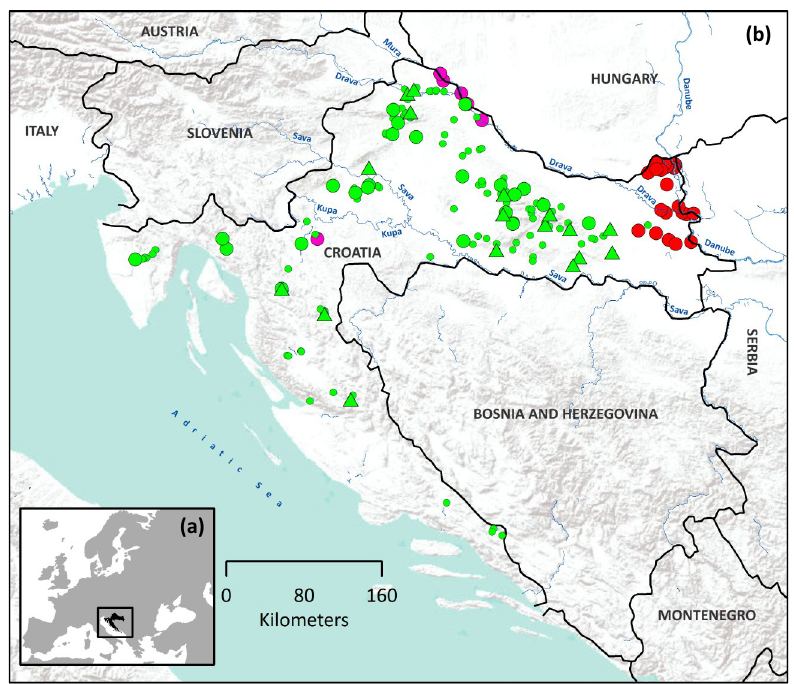
Figure 5. (a) Position of Croatia in Europe and (b) Geographical distribution of indigenous Astacus astacus and the two NICS, Pacifastacus leniusculus and Faxonius limosus in Croatia. Pink dots— P. leniusculus ; red dots— F. limosus ; small green dots— A. astacus occurrences; bigger green dots— A. astacus populations included into mtDNA analyses; green triangles— A. astacus populations included in both mtDNA and microsatellites analyses. Map was produced in ArcGIS 10.3 program package by authors of this